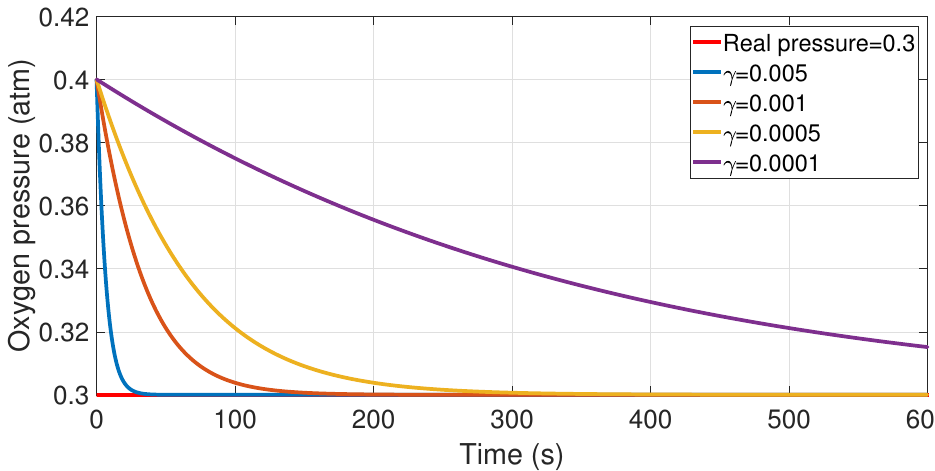
Figure 4. Estimator behavior with different values γ